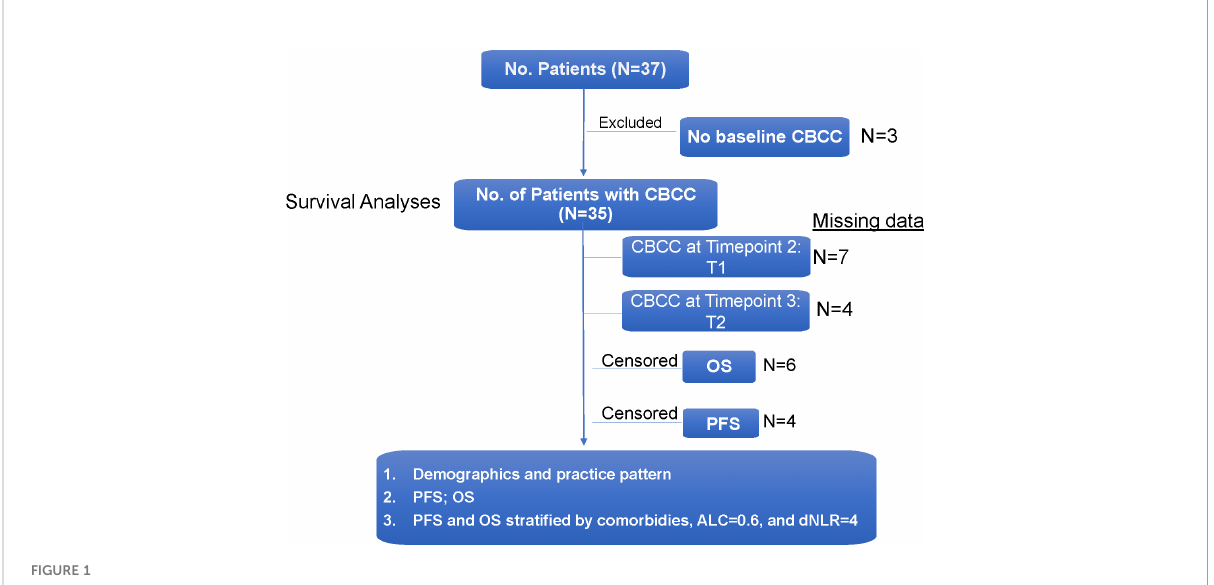
FIGURE 1 Summary of Study